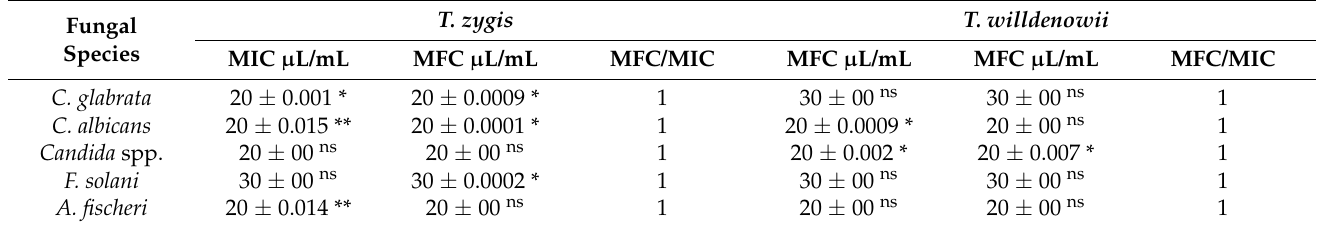
Figure 5. Antifungal activity of the essential oil of T. willdenowii tested on C. albicans (L13), C. glabrata (L14), Candida spp. (L15), F. solani (H13), and A. fischeri (G2). Table 10. MIC and MFC values of T. zygis and T. willdenowii essential oils. Table 9. Effect of the EO on the growth of yeasts and molds. T. zygis T. willdenowii Fungal Species MIC µ L/mL MFC µ L/mL MFC/MIC MFC µ L/mL MFC µ L/mL MFC/MIC C. glabrata Candida spp. F.